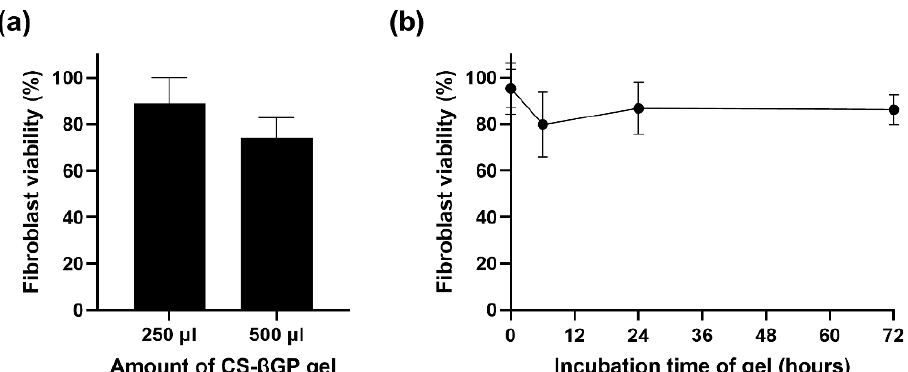
Figure 6. Effect of sterile chitosan with β -glycerophosphate (CS- β GP) on human dermal fibroblast cell viability. ( a ) Fibroblast cells were covered with 250 µL or 500 µL of sterile CS- β GP for 24 h. ( b ) Fibroblast cells were treated for 24 h with 0.9% NaCl previously incubated with sterile CS- β GP gel for up to 72 h to observe unwanted cytotoxic effect of components released from the gel. Fibroblast viability was measured using the CellTiter-Glo viability assay. Data are expressed as mean ± standard deviation (n = 3).